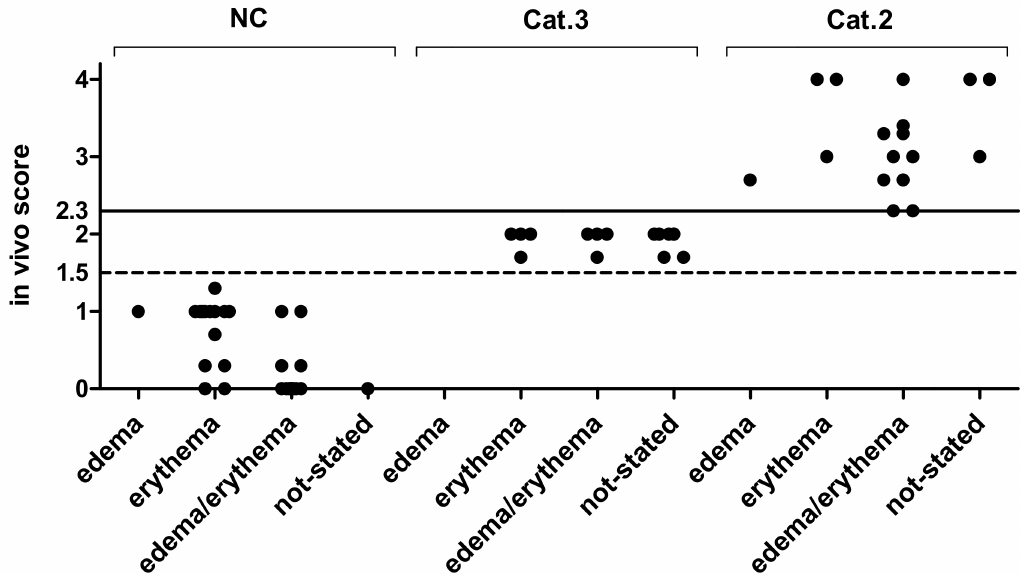
Figure 5. Scatter plot of edema/erythema in vivo scores of 86 chemicals excluding Cat 1 chemicals according to irritancy category (NC, Cat 3, and Cat